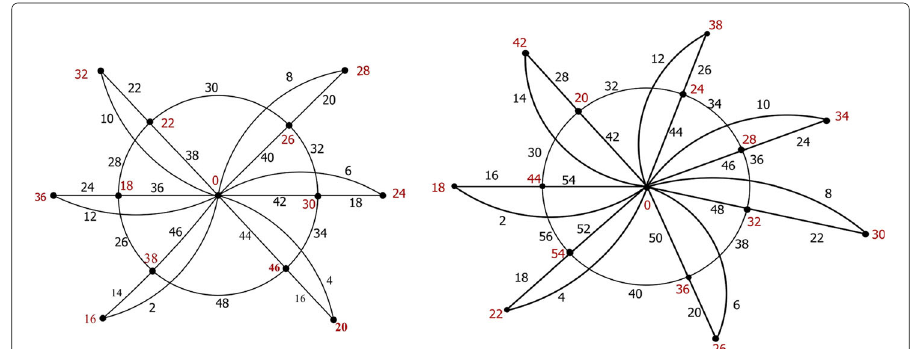
Fig. 21 An edge even graceful labeling of The flower graphs FL(6) and